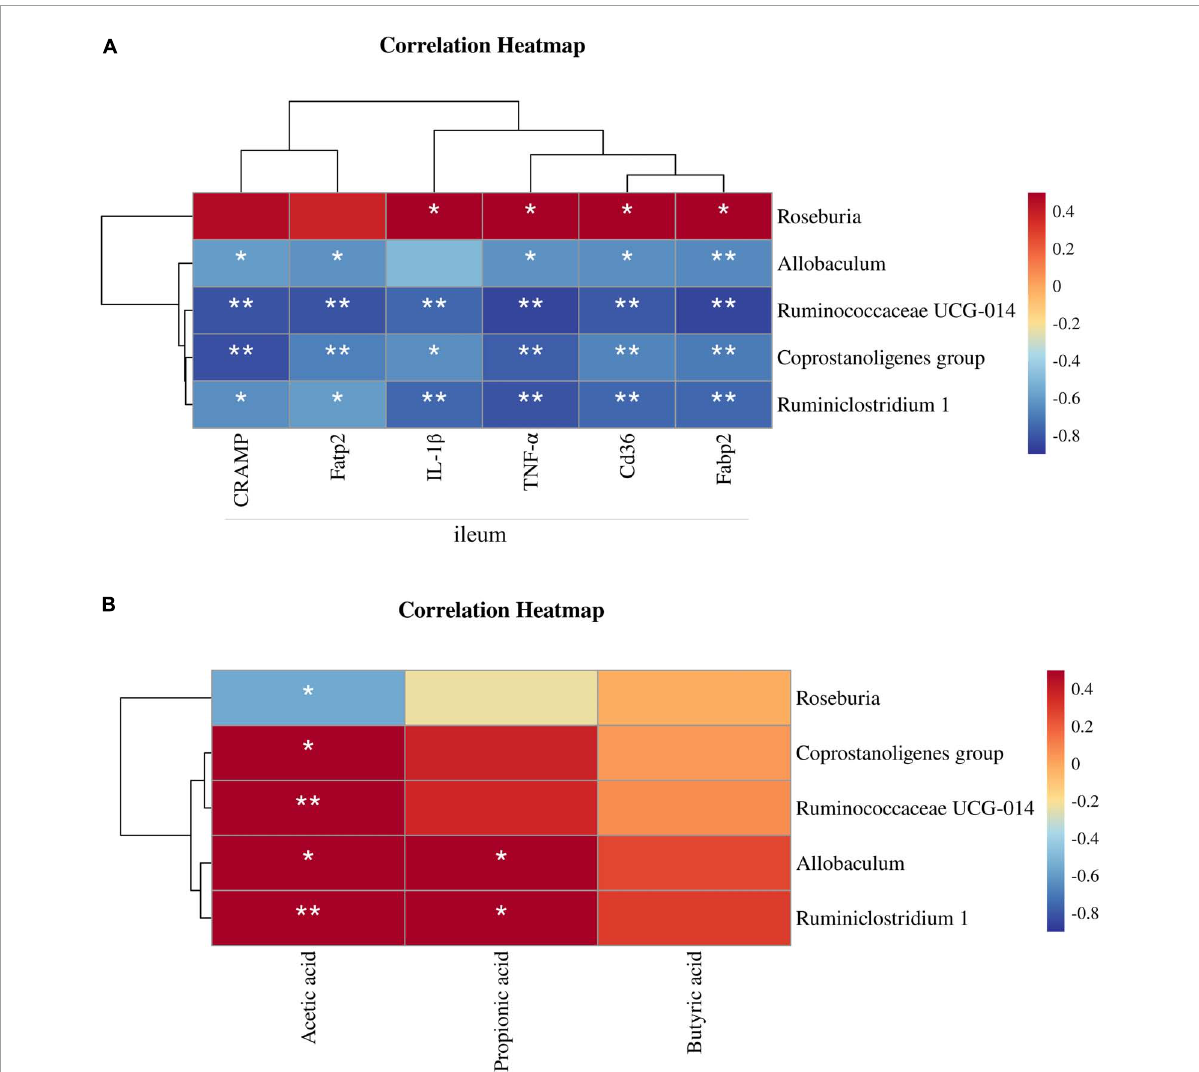
FIGURE8 Correlation between gut microbiota and NAFLD parameters. (A) Heatmap of the Spearman’s correlations between the bacterial genera and the levels of ileum mRNAs. (B) Heatmap of the Spearman’s correlations between the bacterial genera and the SCFA contents. The Spearman correlation coefficients are shown in different colors. *P < 0.05, **P <